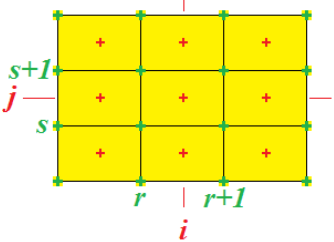
Figure 2. Arrangement of a centered finite differences